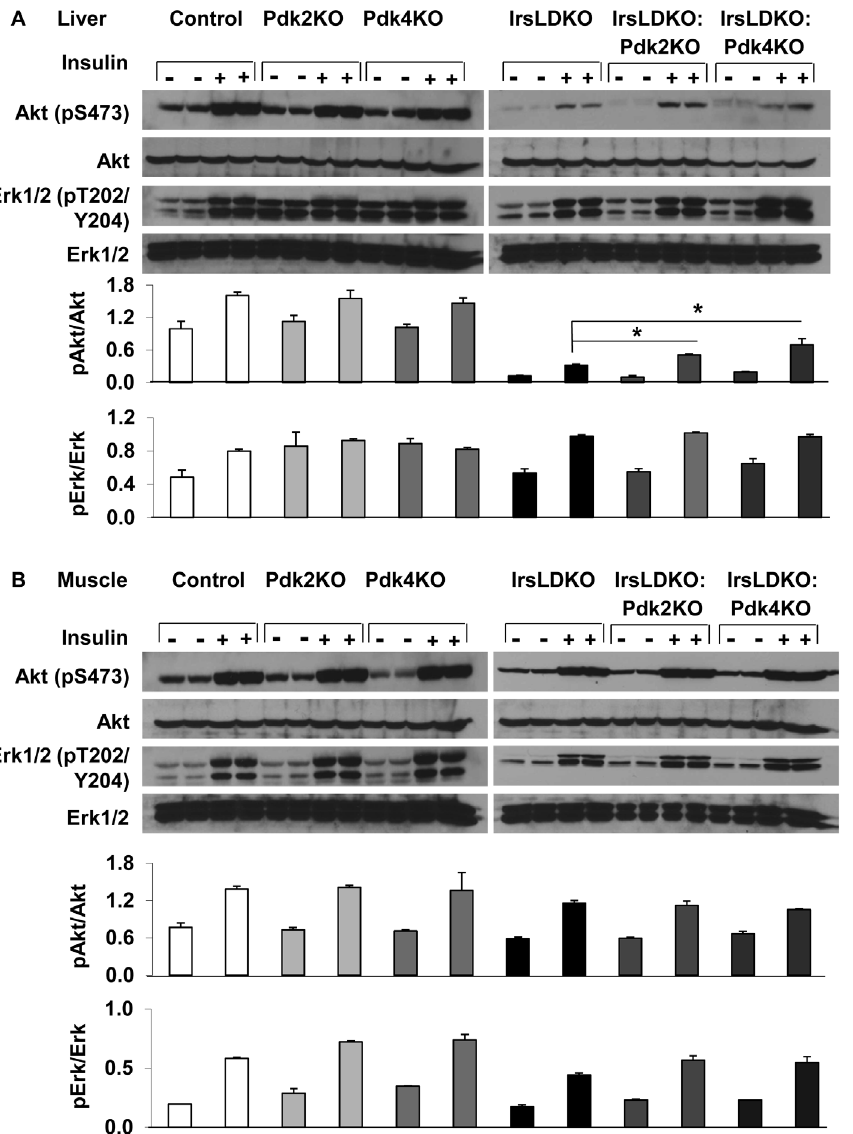
Figure 5. Insulin signaling analysis in the control and knockout mice. A and B, Animals were stimulated with 5 units of human insulin (saline as a vehicle control) for 3 min before liver and skeletal muscle samples were collected for Akt and Erk phosphorylation analyses. Western blot signals were quantified using the Quantity One software (Bio-Rad). Data are presented as means 6 SEM. *, P , 0.05 relative to corresponding controls.